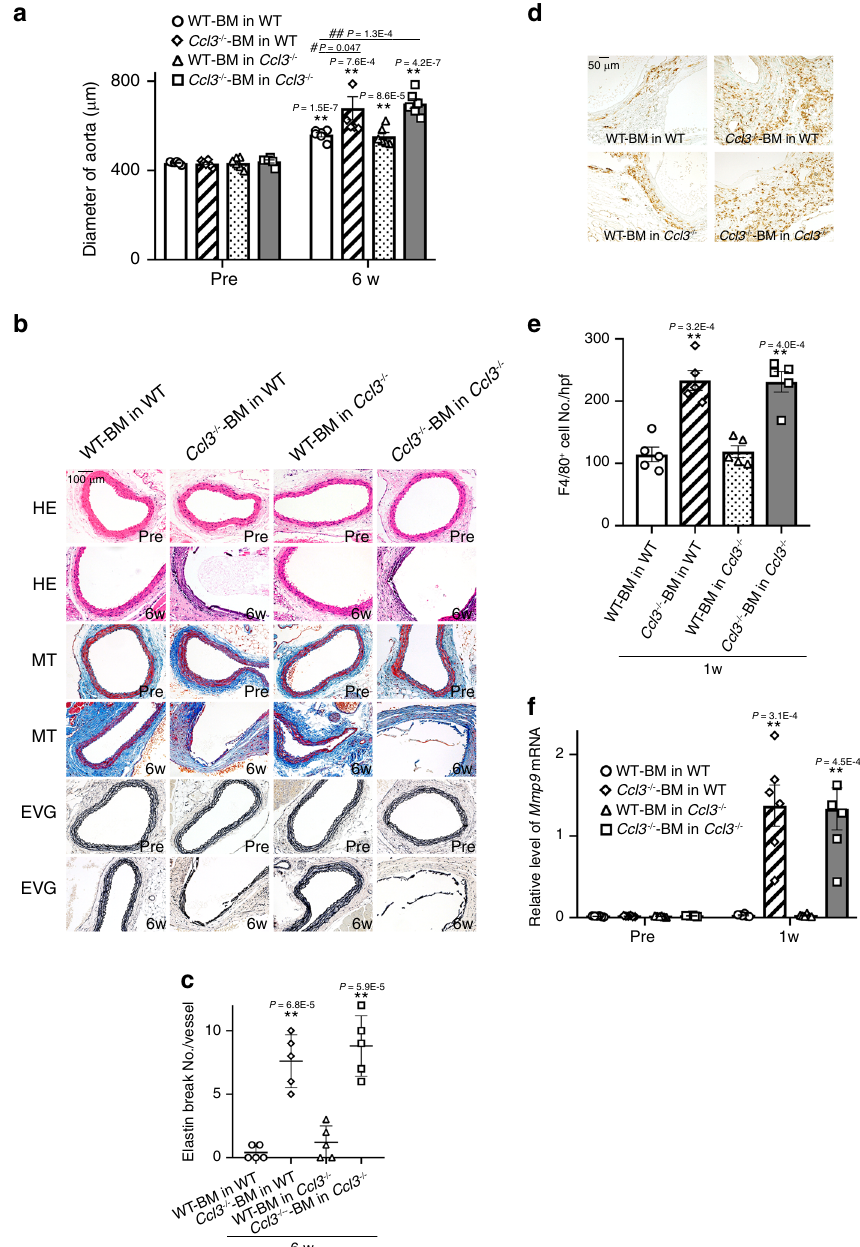
Fig. 4 Effects of BM transplantation between WT and Ccl3 − / − mice on CaCl 2 -induced AAA formation. a Aortic diameters in BM chimeric mice after CaCl 2 treatment ( n = 6 in each group). ** P < 0.01, vs. pretreatment in each strain; ## P < 0.01, # P < 0.05, vs. CaCl 2 -treated WT mice transplanted WT-BM cells. b Histopathological analysis of the aortas obtained from BM chimeric mice after CaCl 2 treatment. Representative results from four independent experiments are shown. Scale bar, 100 µ m. c Quanti fi cation of the number of elastin breaks per vessel ( n = 5 in each mouse strain). ** P < 0.01, vs. WT-BM in WT. d Macrophage accumulation into aortic tissues of BM chimeric mice after CaCl 2 treatment. Representative results from fi ve independent experiments are shown. Scale bar, 50 µ m. e Macrophage numbers were measured ( n = 5 in each mouse strain). ** P < 0.01, vs. WT mice transplanted WT-derived BM cells, by unpaired two-sided Student ’ s t test. f Intra-aortic Mmp9 expression in BM chimeric mice after CaCl 2 treatment ( n = 6 in each mouse strain). ** P < 0.01, vs. pretreatment in each strain. Unpaired two - sided Student ’ s t test was used in ( a ), ( c ), ( e ), and ( f ). Data are presented as mean values ± from Ccr5 − / − but not Ccr1 − / − mice (Fig. 8b). The potential capacity expression (Fig. 8g). Thus, the CCL3 – CCR5 axis could depress of p38 MAPK to inhibit LPS-induced Mmp9 expression 32 prompted Mmp9 gene expression by activating p38 MAPK in macrophages. us to evaluate MAPK signaling pathways. Indeed, CCL3 enhanced When CaCl 2 -treated WT mice were administered with SB239063, aneurysm formation was signi fi cantly exaggerated, compared with PMA-induced p38 MAPK phosphorylation but decreased ERK vehicle treatment (Fig. 8h). Thus, the activation of p38 MAPK phosphorylation in macrophages (Fig. 8c – f). Moreover, a speci fi c p38 through the CCL3 – CCR5 axis can be protective for CaCl 2 -induced MAPK inhibitor, SB203580, but not an ERK inhibitor, PD98059, aneurysm formation. abrogated CCL3-mediated suppression of PMA-induced Mmp9